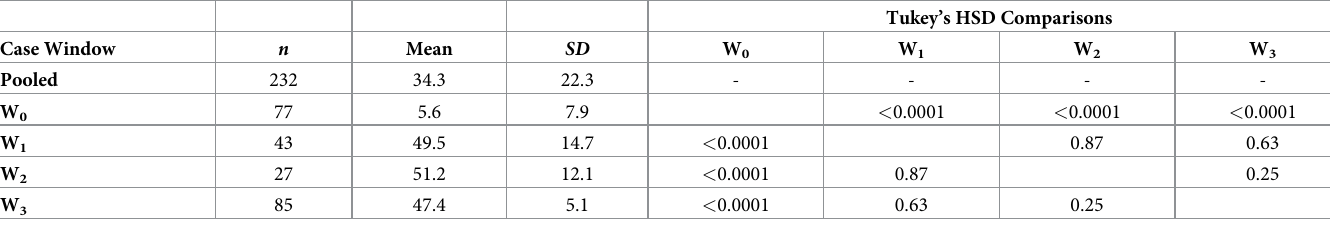
Table 5. One-way analysis of variance of the stringency index by case window, Zambia.